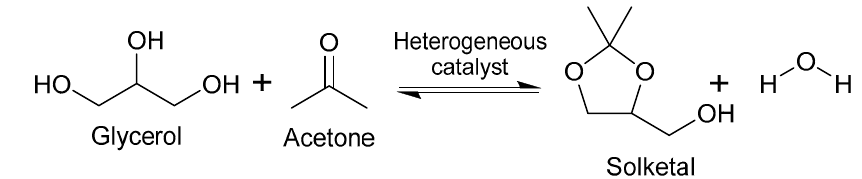
Figure 3. Synthesis scheme of glycerol to solketal. Table 5. Glycerol-to-solketal over clay minerals.